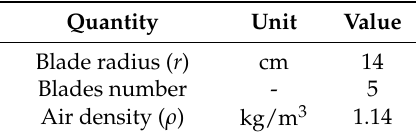
Table 1. Characteristics of the wind turbine.